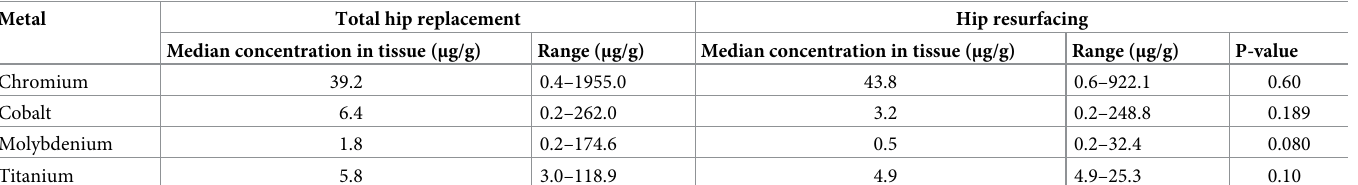
Table 2. Median values with respected p-values and ranges for periprosthetic tissue metal concentrations in patients with total hip replacements (n = 87) and hip resurfacings (n = 20). Metal Total hip replacement Hip resurfacing Median concentration in tissue ( μ g/g) Range ( μ g/g) Median concentration in tissue ( μ g/g) Range ( μ g/g) Chromium